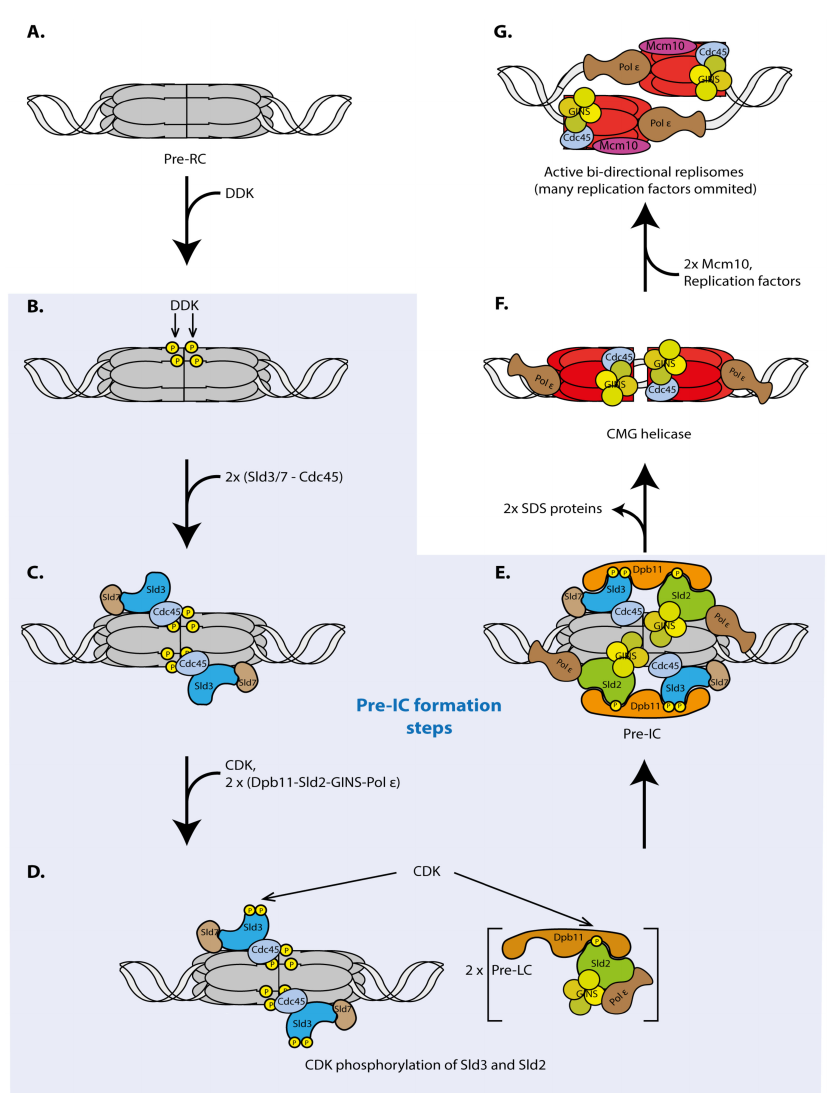
Figure 2. Molecular mechanisms of origin firing. Schematic representation of origin firing—a pre-RC ( A ) being converted into two active bi-directional replisomes ( H )—and the steps required ( B – G ), as detailed in the main text. The blue box indicates pre-IC formation ( B – F ). Some details shown are hypothetical. For example, we speculate that two pre-IC complexes are required to originate two bi-directional forks but other models are also